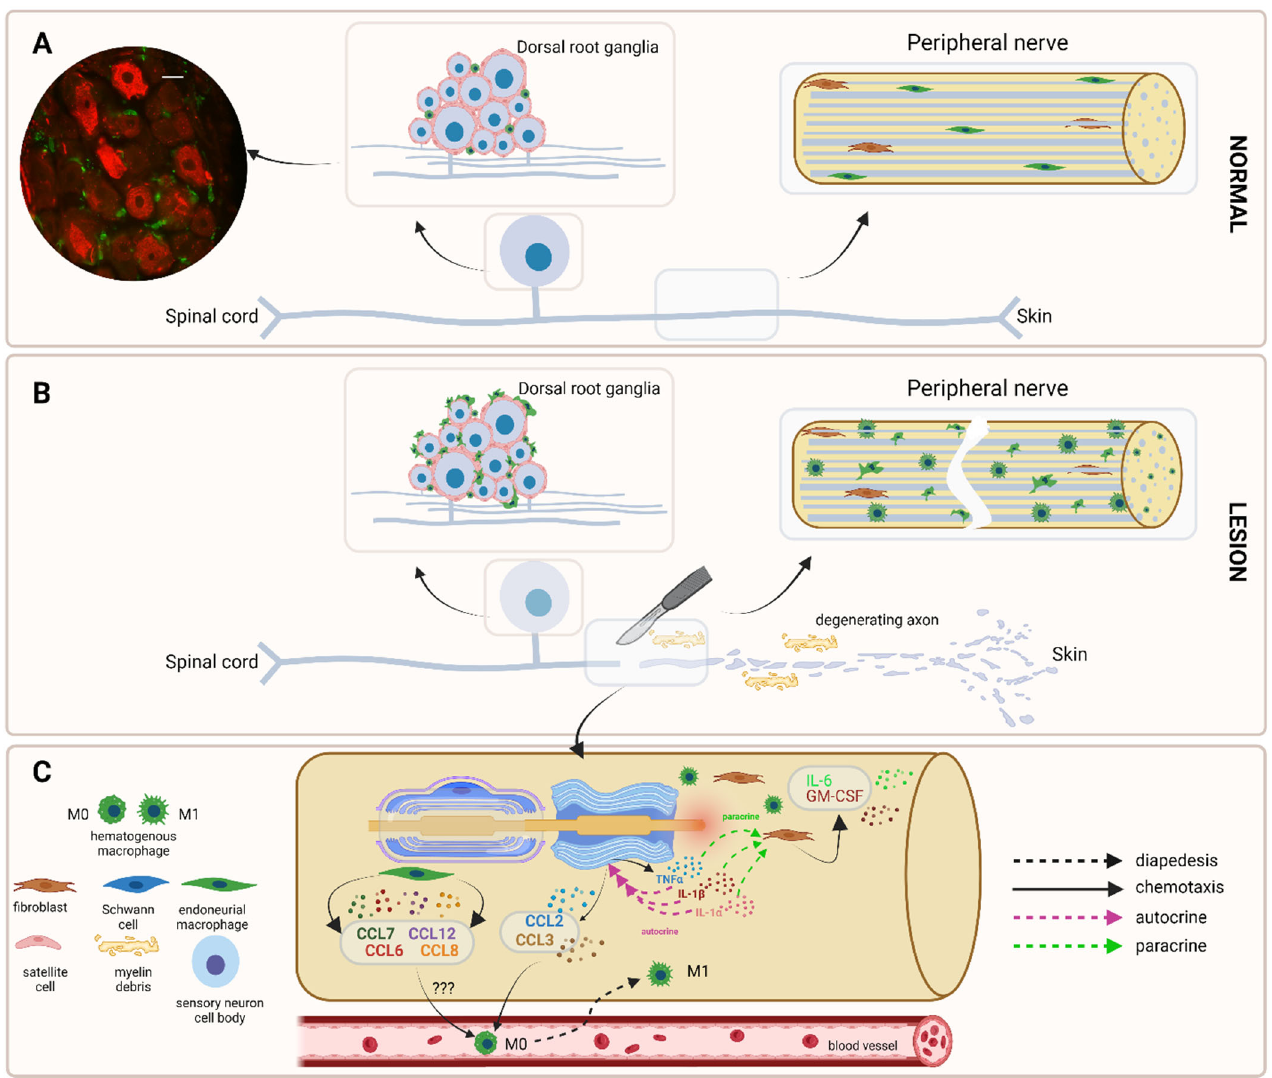
Figure 2. After a peripheral nerve lesion, macrophages are attracted to the lesion site. ( A ) Graphic representation of a normal DRG. Peripheral nerve consists of nerve fibers of different diameters and degrees of myelination, with elongated macrophages oriented along the longitudinal axis and scattered between nerve fibers. In normal conditions, few macrophages are scattered between DRG neurons as well. To the left, DRG immunostaining showing a small number of Iba1 (+) macrophages (green) scattered among large NF200 (+) neurons (red). Scale bar—20 µ m. ( B ) Graphic representation of the peripheral nerve lesion site, where numerous endoneurial and hematogenous macrophages are attracted. ( C ) Signaling pathways that attract macrophages to the peripheral nerve lesion site. Lesioned Schwann cells release cytokines that in an autocrine manner induce the secretion of chemoattractant chemokines (CCL2, CCL3), which further on recruit hematogenous macrophages to the lesion site. Endoneurial macrophages, activated after the lesion, also release chemoattractant chemokines, which further increase the recruitment of hematogenous macrophages to the lesion site. IL-6 and GM-CSF secreted by activated fibroblasts do not directly participate in the recruitment of macrophages. Legend : DRG—dorsal root ganglia; Iba1—ionized calcium-binding adaptor molecule 1; NF200—neurofilament 200; CCL2, -3—chemokine (C-C motif) ligand 2, -3; IL-6—interleukin 6; GM-CSF—granulocyte-macrophage colony-stimulating